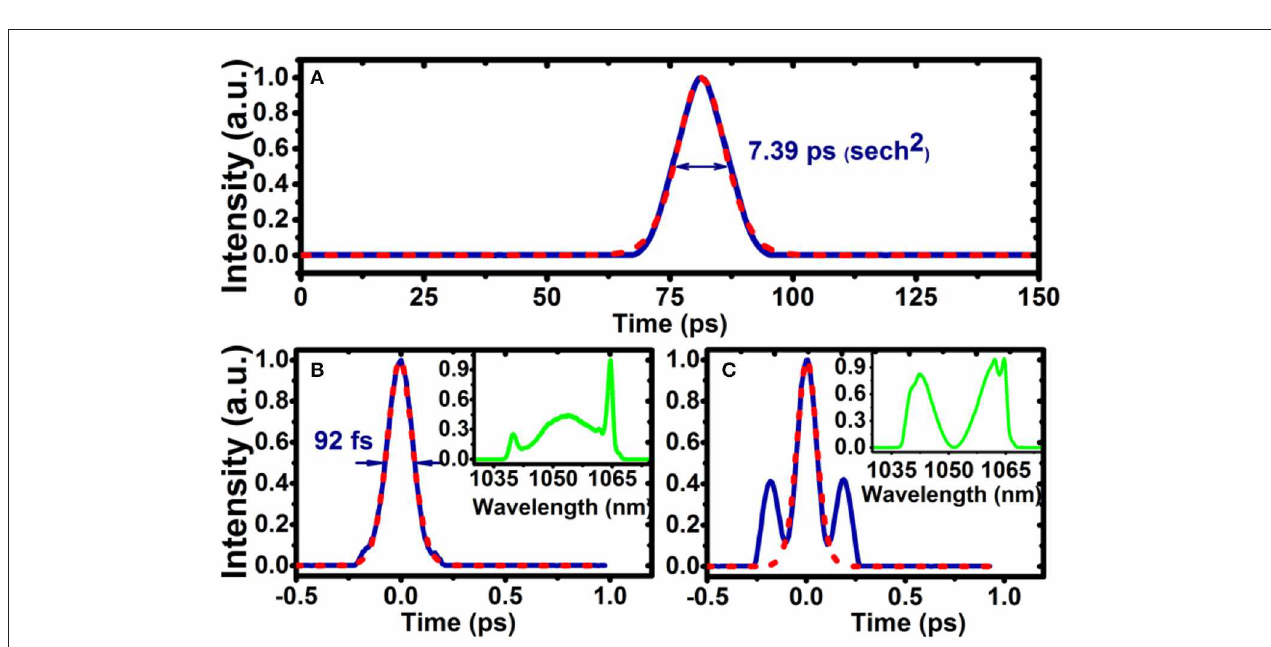
FIGURE 3 | (A) Chirped pulse duration measured directly from the main port of the presented laser configuration. (B) Measured pulse duration after the 1000 lines/mm transmission grating-pair compressor. (C) Measured compressed pulse duration for pulses from the ejection port. The red dashed lines in correspond to the sech 2 fitting of pulses. The insets in (B) and (C) correspond to the mode-locked spectra from the main port and the ejection port, respectively.